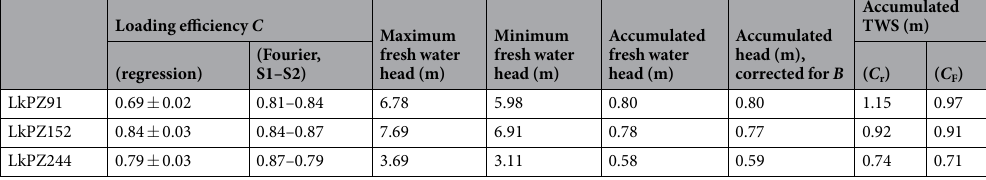
Table 2. Monsoon seasonal TWS accumulation over the Laksmipur piezometer sensing areas. Ranges of values for loading efficiency, C , by regression analysis are ± twice the standard error; ranges of C by Fourier analysis are by reference to the S 1 and S 2 atmospheric frequency components determined independently. C r denotes application of C as determined by regression; C F denotes application of C as determined by